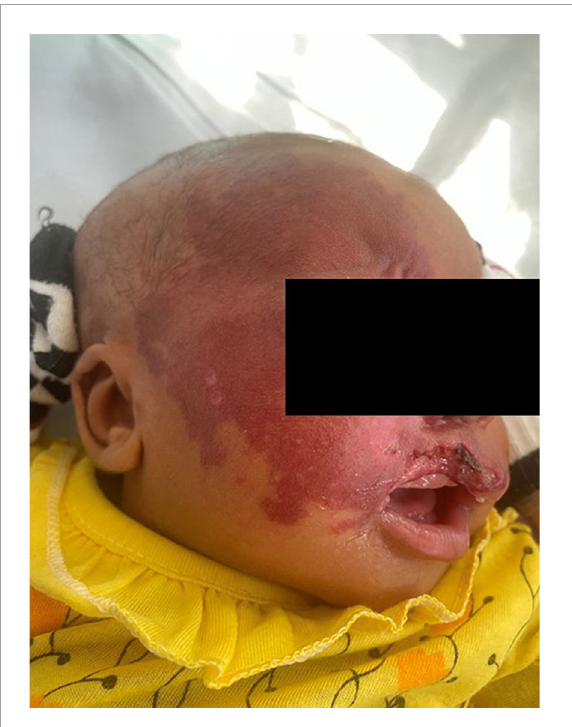
FIGURE5 Neonate with an aggressive infantile hemangioma of the cheek and periorbital region leading to a localized steal-effect with subsequent necrosis on the upper lip. Conservative treatment with propranolol p.o. (hemangiol starting dose 0.5 ml for 3 kg child) was initiated and further active surveillance was chosen as treatment strategy for this